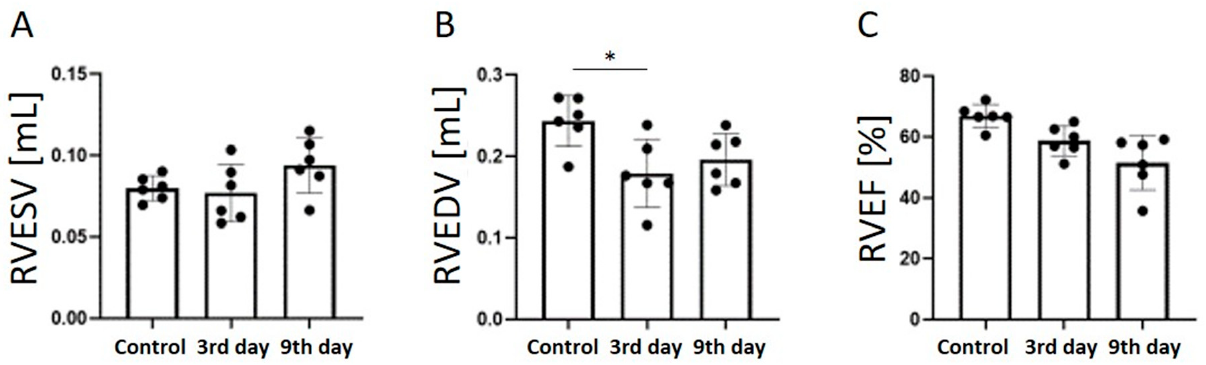
Figure 5. Graphs quantifying RVESV ( A ), RVEDV ( B ), and RVEF ( C ) in the control group, 3 days after the onset of myocardial infarction, and 9 days after the onset of myocardial infarction. RVESV, right ventricular end-systolic volume; RVEDV, right ventricular end-diastolic volume; RVEF, right ventricular ejection fraction. * p < 0.05.